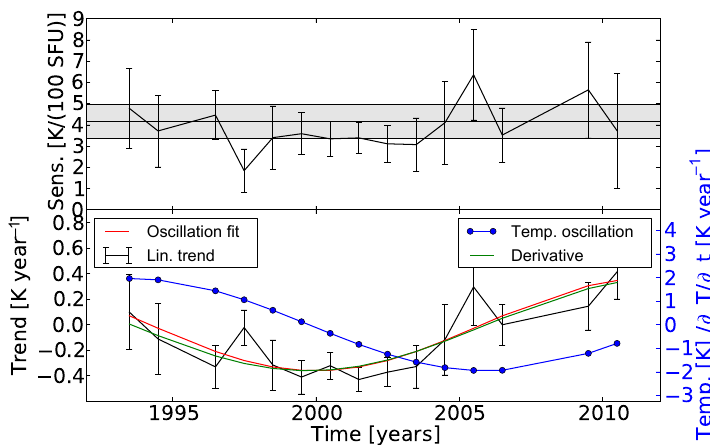
Figure 14. The upper panel shows the sensitivity to the solar activity derived for different 11-year time intervals. All values are displayed at the middle of the corresponding time interval. The error bars show the 1 σ uncertainties. The grey shaded area marks the range of the sensitivity derived in Sect. 4.3 for the fit using the solar cycle and one oscillation ( C solar = (4.1 ± 0.8)K ( 100SFU ) − 1 ). The lower panel of the figure shows the corresponding linear trends for each time interval in black. A sinusoid fitted to these values is shown in red. The result for the 25-year temperature oscillation (see Sect. 4.3) is shown as a blue curve and the corresponding derivative of the oscillation is shown as a green curve with a second axis to the